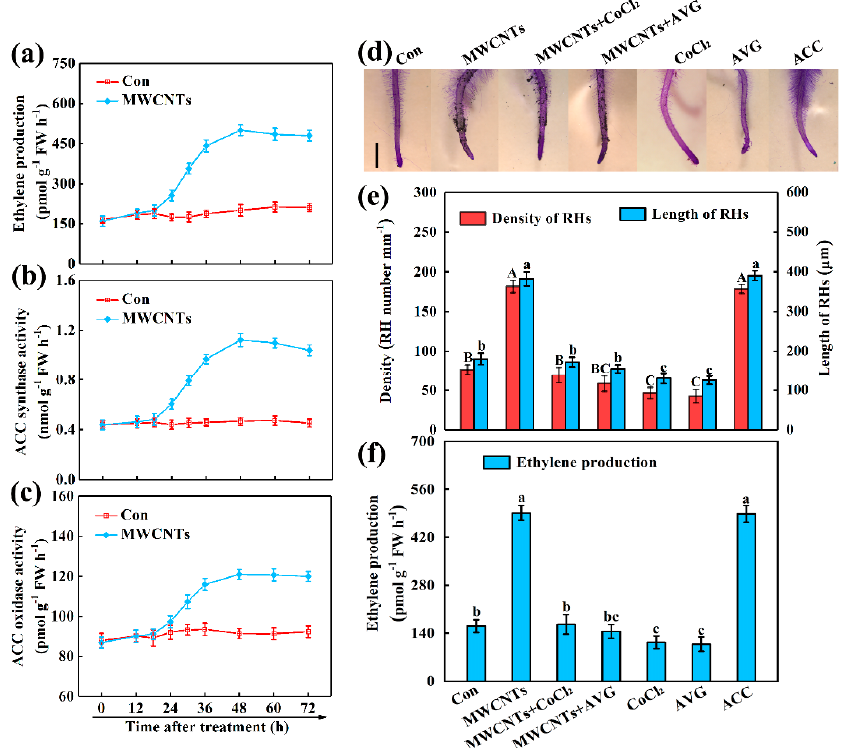
Figure 2. MWCNTs-induced ethylene production and root hair development were blocked by the removal of endogenous ethylene. Two-day-old rapeseed seedlings were treated with 100 mg/L MWCNTs, 10 μ M CoCl 2 , and 3 μ M AVG, alone or in combinations. The sample without chemicals was the control (Con), and 3 μ M ACC alone was used as a positive control. Afterward, the time-course changes in ethylene production ( a ), ACC synthase ( b ), and ACC oxidase activities ( c ) were detected (in control and MWCNTs treated samples). After treatment for 3 days, corresponding photographs of the seedling’s roots were done ( d ), and the root hair (RH) density and length ( e ), and ethylene production ( f ) were determined. Scale bar = 1 mm. Within each set of experiments, bars with different letters were significantly different at p < 0.05, according to Duncan’s multiple range test.